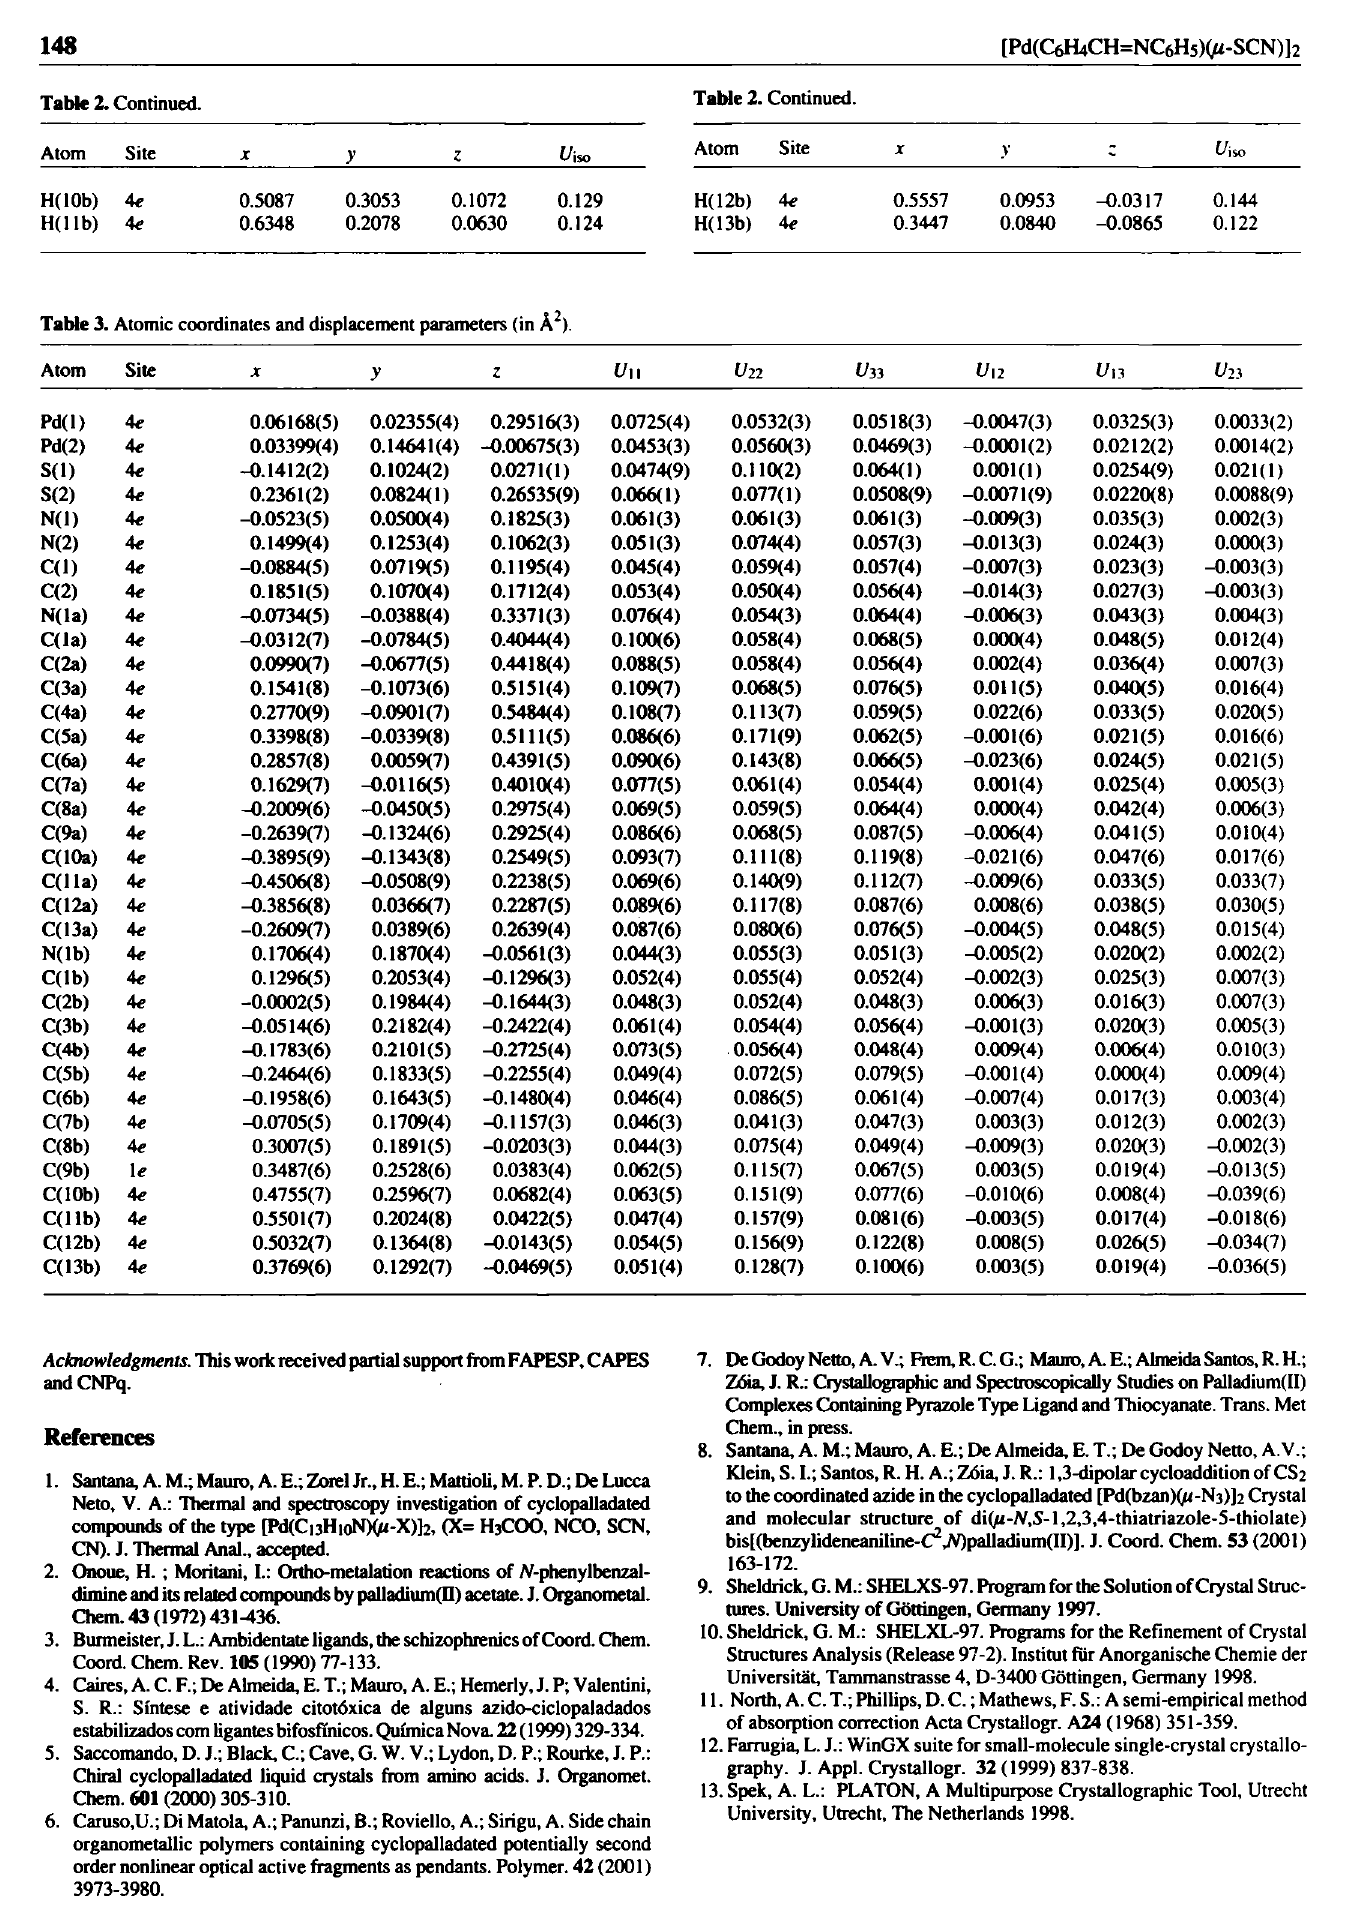
Table 3. Atomic coordinates and displacement parameters (in À 2